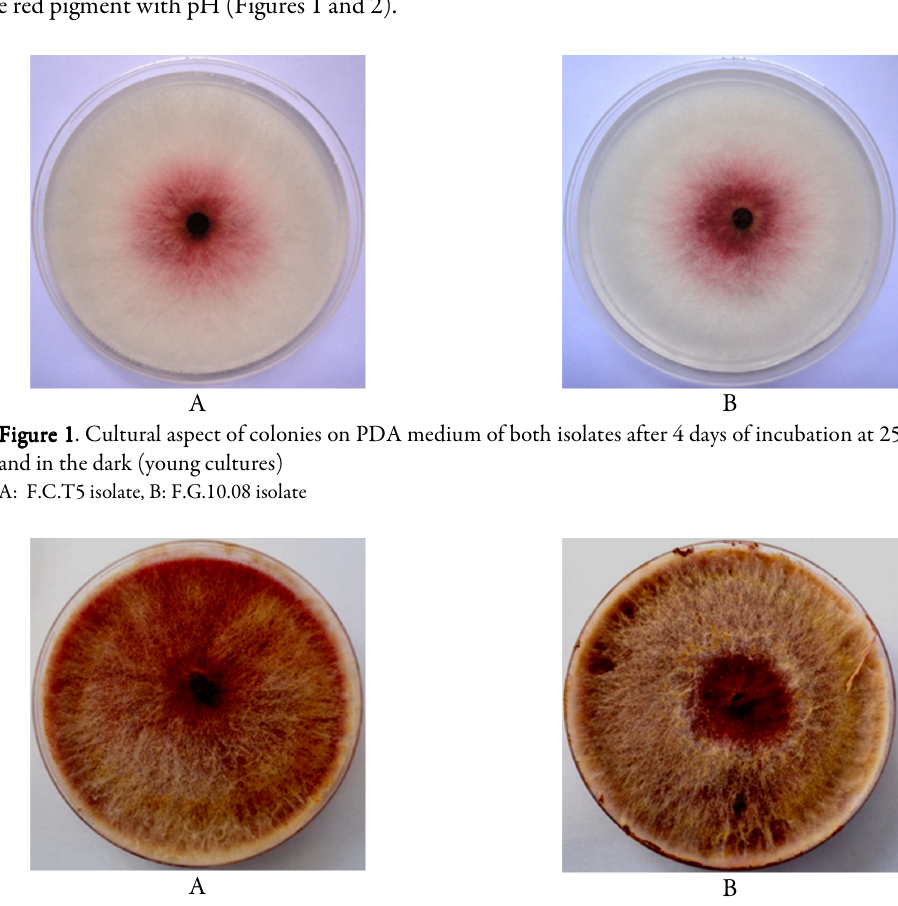
Figure 2. Cultural aspect of colonies on PDA medium of both isolates after 20 days of incubation at 25 °C and in the dark (Aged cultures) A: F.C.T5 isolate, B: F.G.10.08